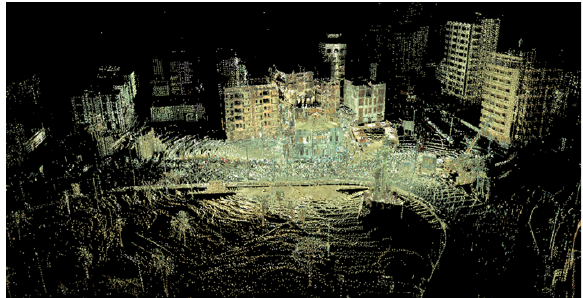
Figure 4 The coordinates map for each point.